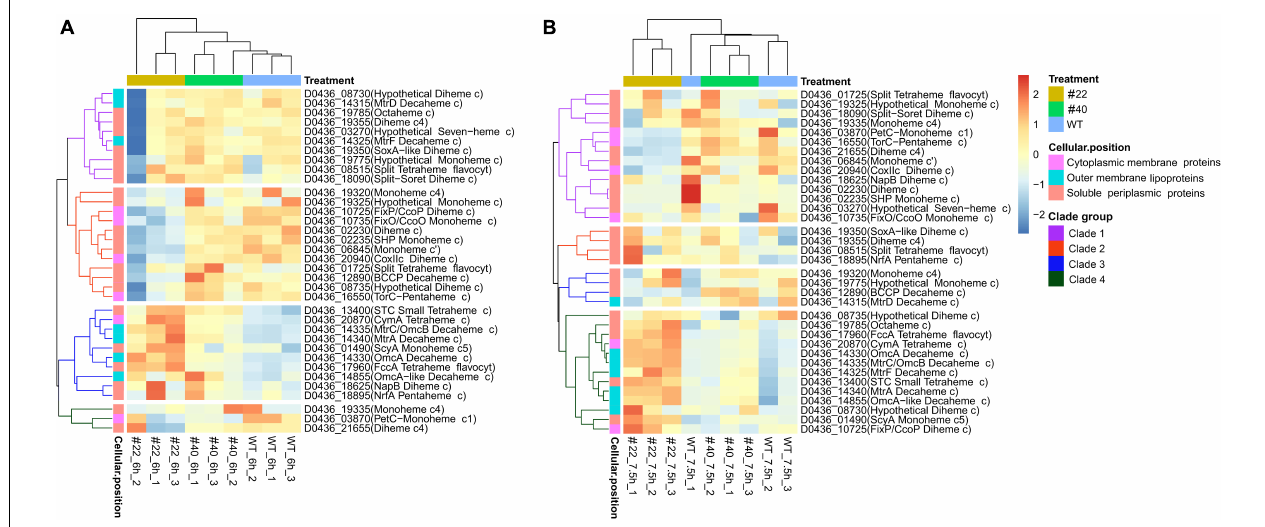
FIGURE 4 | Comparison of the expression level of cytochrome c coding genes between the strains. Expression level of cytochrome c coding genes at 6 h (A) and 7.5 h (B) . Sample #22_6h_2 is an outlier (A) .